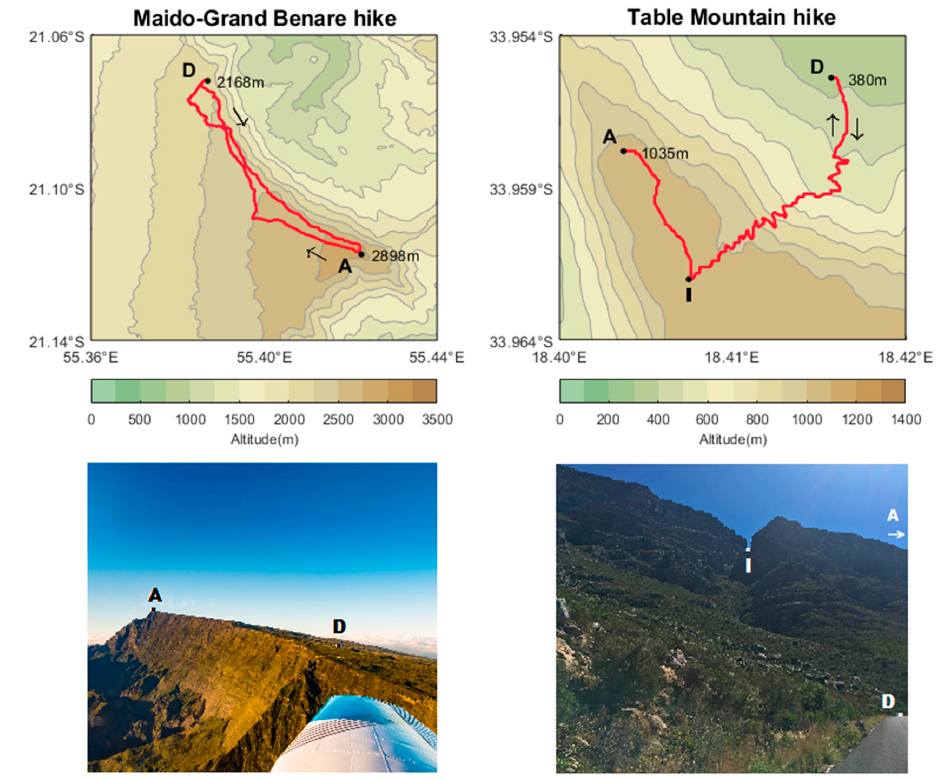
Figure 2. On the top panels, the red lines show the route of the Maïdo–Grand Bénare hike (left side) and Table Mountain hike (right side). The departure (D), intermediate (I), and arrival (A) locations are indicated as well, in addition to the direction of the hike. The lower panels present photos of the 2 sites on the days of the hikes.